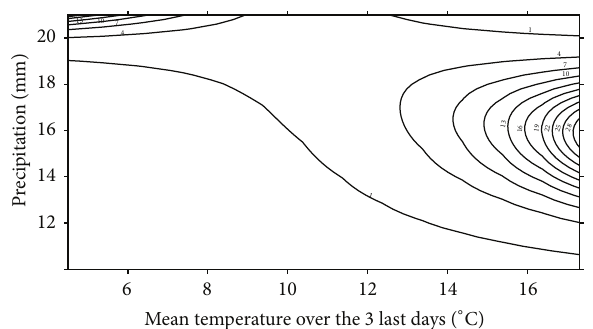
Figure 5: Contour plot of predicted numbers of migrating L. vul- garis per observation unit, as a function of daily mean temperatures ( ∘ C) over the three last days since the specific observation ( 𝑥 -axis) and accumulated daily precipitation in mm ( 𝑦 -axis). Only every third contour is shown in the plot to ease visualization.